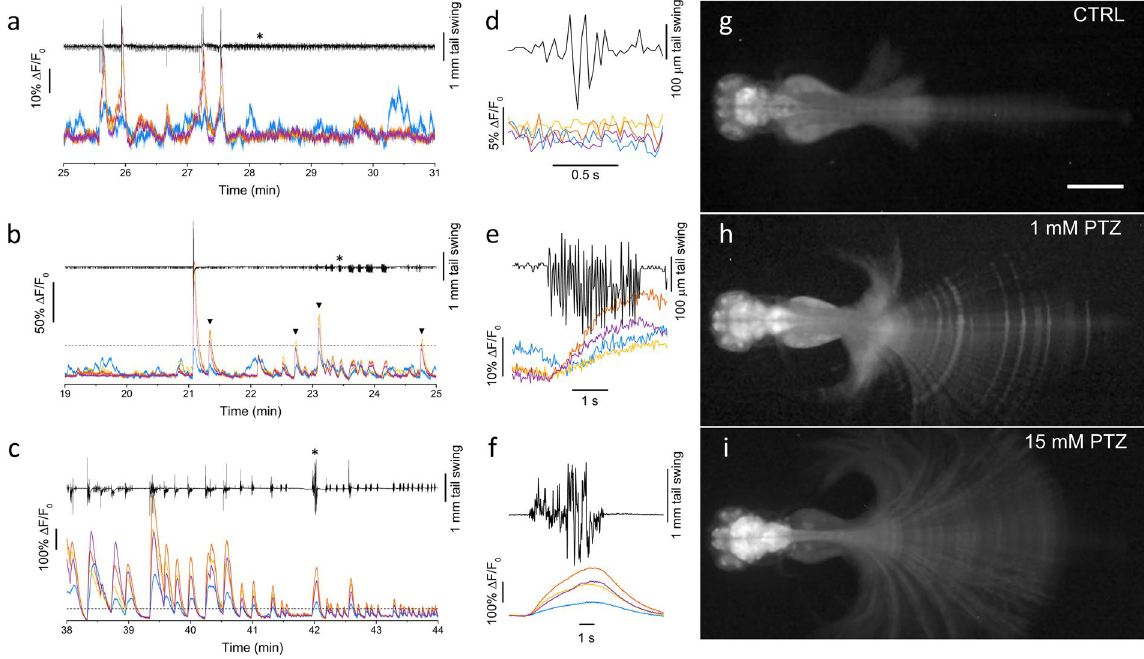
Figure 3. Simultaneous measurement of brain activity and tail movement. ( a ) Time trace of tail movement (black line) and fluorescence ( Δ F/F 0 ) analysed in control conditions (0 mM PTZ) for four brain regions color- coded as in Fig. 1a. The traces show correlations between fluorescence peaks and tail movements for optic tectum, cerebellum and medulla, while the telencephalon exhibits some degree of activity not correlated with tail movement. ( b-c ) Tail movement and brain activity analysed as in panel a at 1 and 15 mM PTZ, respectively. The dashed lines show a Δ F/F 0 level of 0.4 corresponding to the highest peaks typically measured in control conditions. The arrowheads in panel b highlight peaks overcoming the 0.4 level and not corresponding to large tail movements. ( d-e-f ) Expanded time scale traces of the fragment indicated by the asterisk in a, b and c, respectively. Each panel shows movement and fluorescence traces (color-coded as in panels a-c) corresponding to a typical tail movement observed in the corresponding condition. ( g-h-i ) Fluorescence images of head- restrained larvae (see Methods) in 0, 1 and 15 mM PTZ. Images are maximum intensity projections over a time interval of 10 min, chosen during typical locomotor activity of the tested condition. Panels h and i are displayed with gamma = 0.4 to avoid saturation in the encephalon and still have good contrast on the tail. Scale bar 500 µ